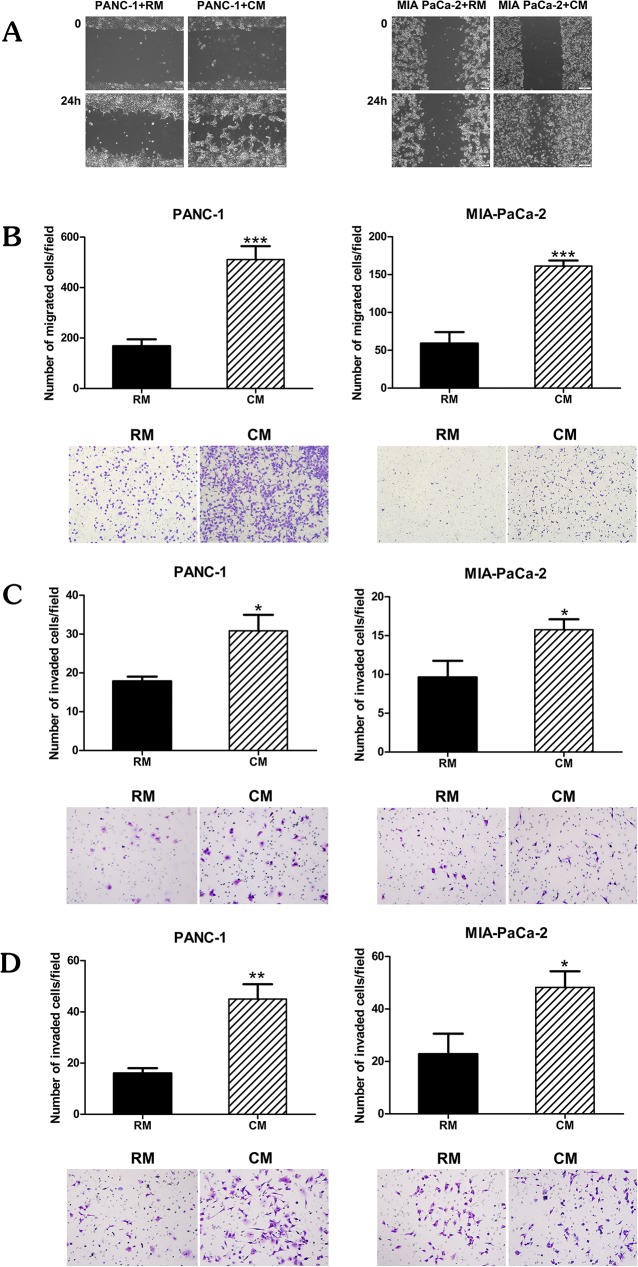
Omental fat CM enhances pancreatic cancer cell migration and invasion.(A) Wound healing scratch assay demonstrating the effect of omental fat CM on PANC-1 and MIA-PaCa-2 cell migration; Scale bar = 200 μm. (B); Modified Boyden chamber assays depicting the effects of omental fat CM on pancreatic cancer cell migration (P< .001); (C) Matrigel invasion chamber demonstrating a significant increase in invasion of PANC-1 and MIA-PaCa-2 cells pre-treated with omental fat CM (P< .05); (D) Increased invasion of PANC-1 and MIA-PaCa-2 cells by using omental fat CM as a chemoattractant (P < .01). The upper panel graphs represent the average of 5 repeated experiments ± SD, and the lower panel depicts representative images (magnification, X100).